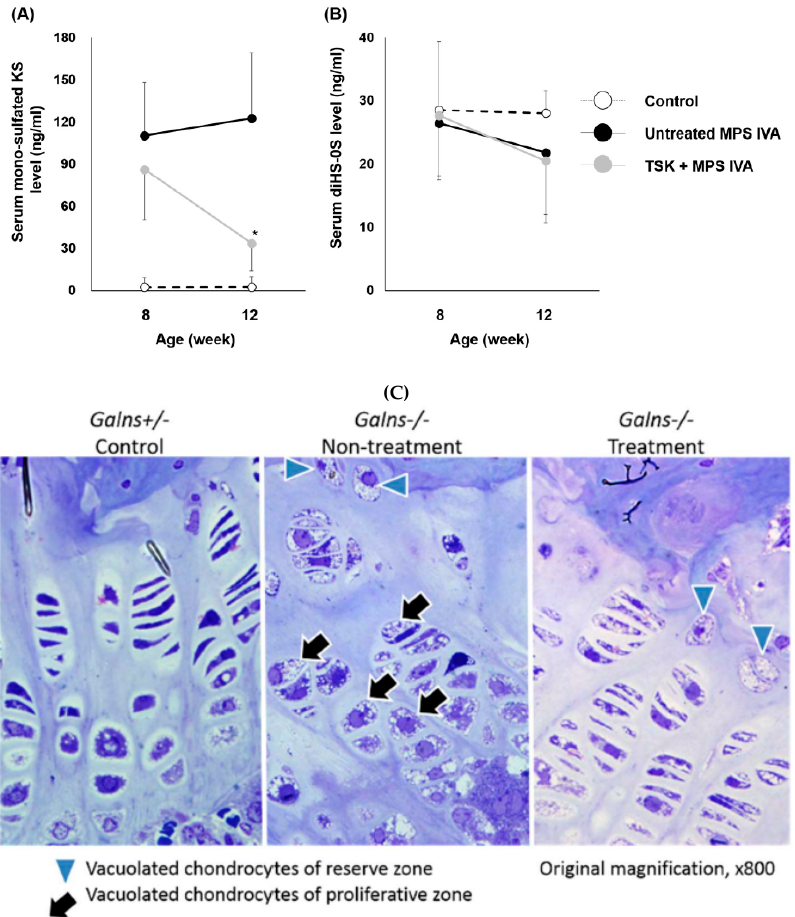
Figure 3. Serum glycosaminoglycan levels and bone pathology of MPS IVA mice after repeated administration of thermostable keratanase. MPS IVA mice were treated with 2 U/kg of thermostable keratanase intravenously 3 times at 0, 4, and 8 weeks of age, and PBS was administered into MPS IVA mice (untreated) and heterozygous mice (control) in the same manner. Serum samples were collected from the superficial temporal vein at the time points of 8 and 12 weeks of age. Tissues were collected at 12 weeks of age. ( A , B ) The level of serum mono-sulfated KS and diHS-0S was measured by LC-MS/MS. n = 7–9. ( C ) Bone pathology in growth plate regions of femur and tibia was evaluated by toluidine blue staining. Statistics were analyzed by one-way ANOVA with the Bonferroni’s post-hoc test. Data are presented as mean ± SD. * p < 0.05 vs. untreated MPS IVA. HS: heparan sulfate, KS: keratan sulfate, TSK: thermostable keratanase. Table 1. Pathological score in growth plate region of femur/tibia of MPS IVA mouse.